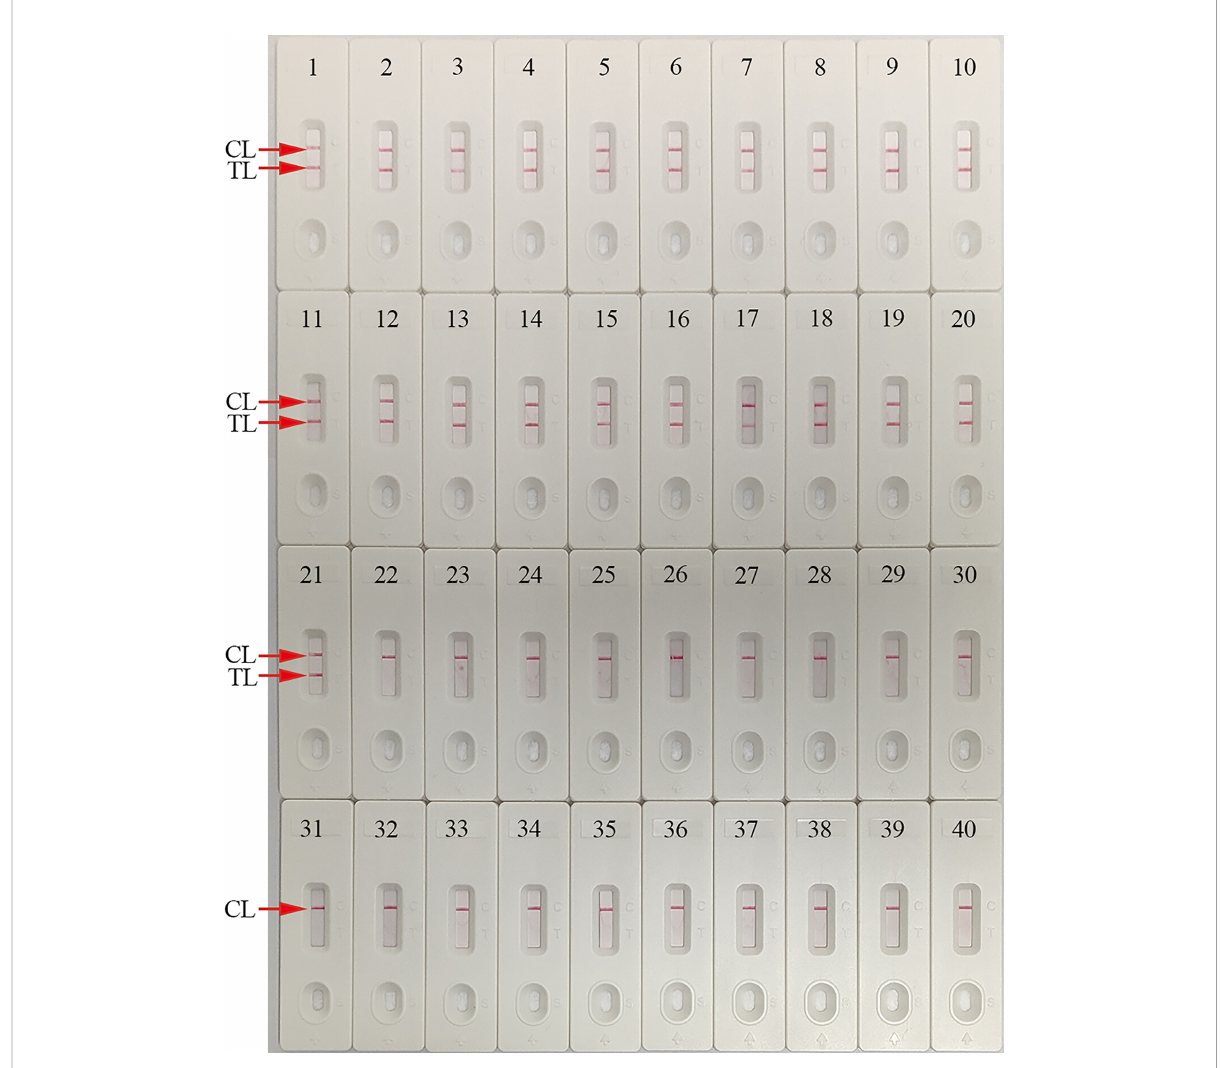
FIGURE 7 Analytical speci fi city of the C. trachomatis -MCDA-AuNPs-LFB assay using different strains. Assay speci fi city was evaluated using different nucleic acids as temperatures, and products were tested using AuNPs-LFB. Biosensors 1 – 14, C. trachomatis serovars A, B, C, D, E, F, G, H, I, J, K, L1, L2, and L3 ompA -plasmids; Biosensors 15 – 21, C. trachomatis (clinical samples); Biosensor 22, Ureaplasma urealyticum ; Biosensor 23, Neisseria gonorrhoeae ; Biosensor 24, Escherichia coli ; Biosensor 25, Staphylococcus aureus ; Biosensor 26, Human papilloma virus; Biosensor 27,